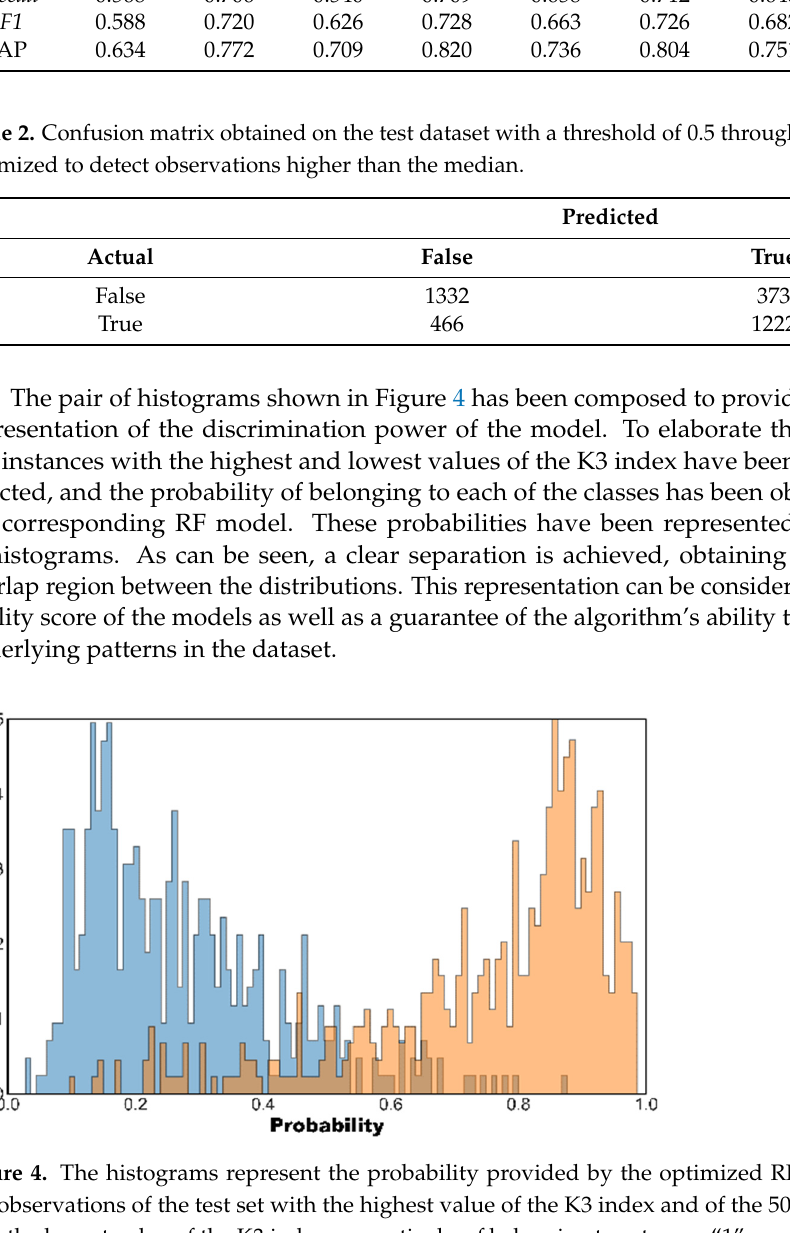
. Figure 5. Boxplots showing the PI of the features through the RF optimized model.